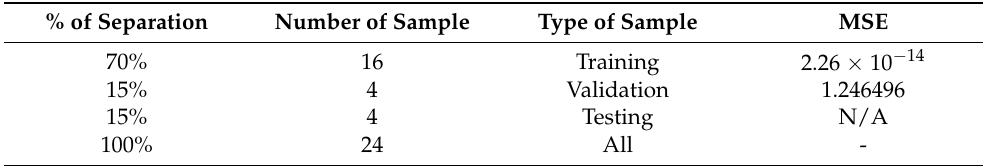
Table A3. Best performance result of the ANN model for anaerobic digestion.